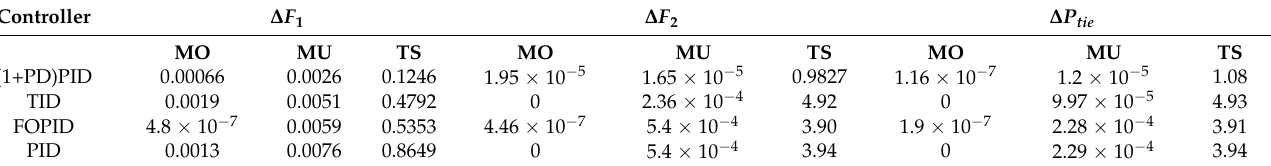
Table 3. The system parameters for 10% load change.